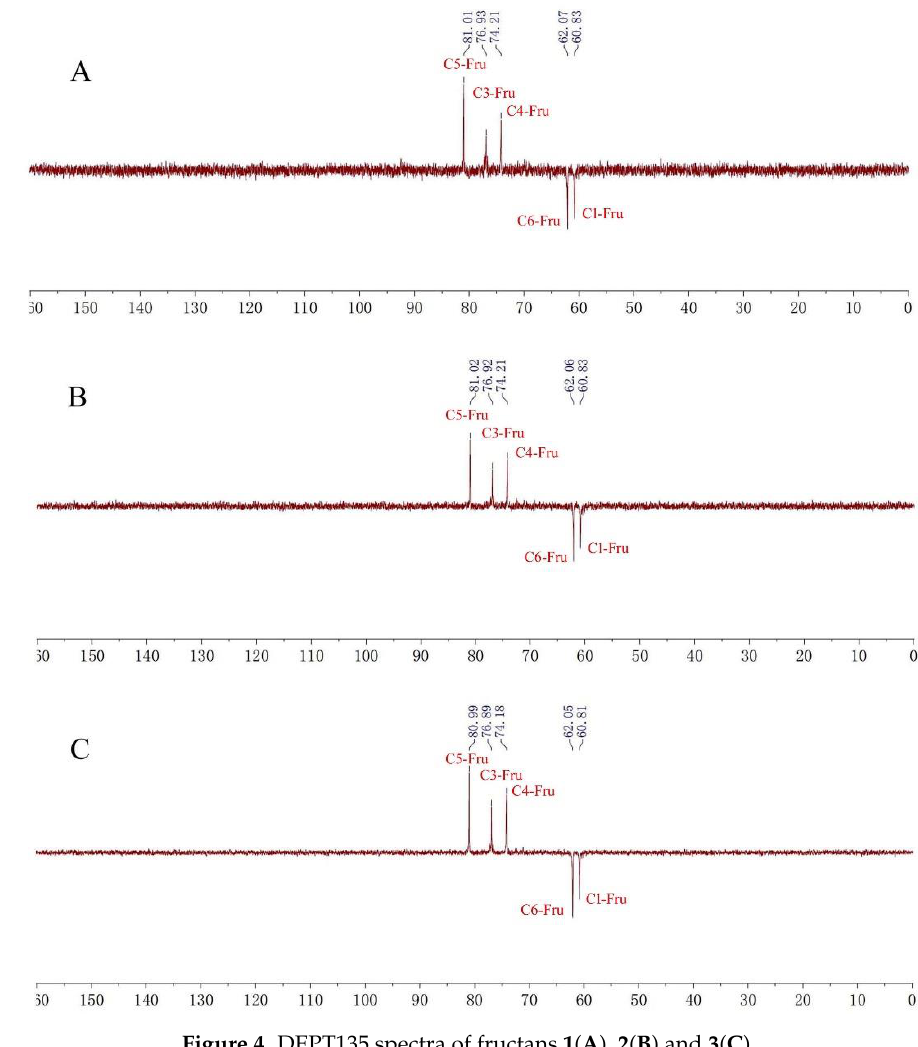
Figure 4. DEPT135 spectra of fructans 1 ( A ), 2 ( B ) and 3 ( C ). Table 1. 1 H- (400 MHz, D 2 O) and 13 C-NMR (100 MHz, D 2 O) chemical shifts in ppm for fructan 1 , 2 and 3 .